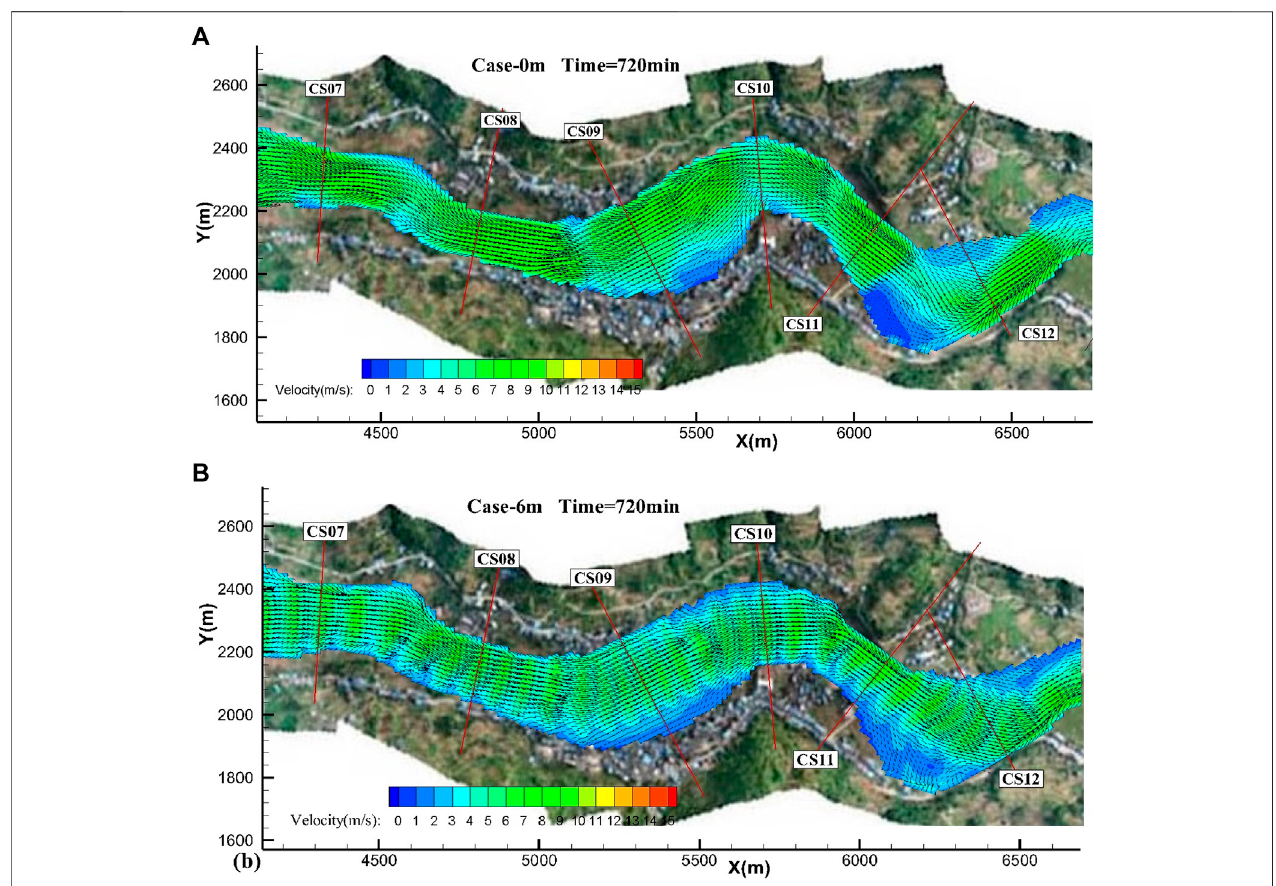
FIGURE 9 | Velocity and depth distribution at Zhongdu Town in case-0m (A) and case-6m (B) .